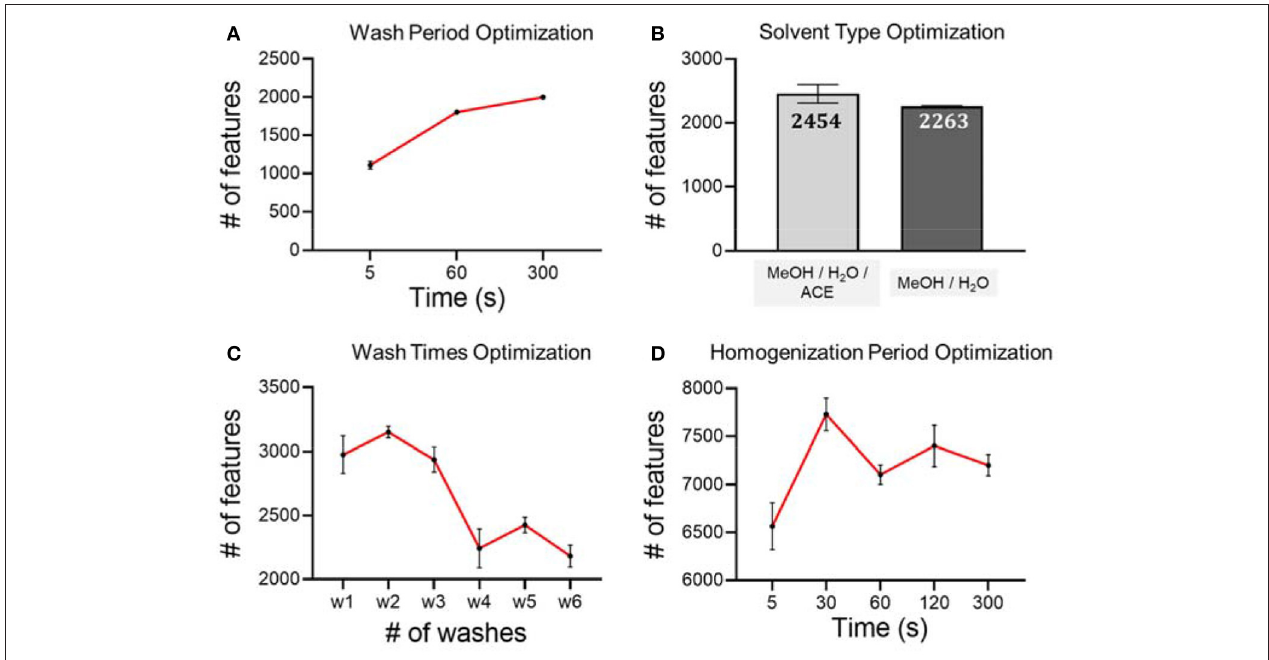
FIGURE 2 | Optimization of experimental conditions using RP ( + ) mode and analytical triplicates. (A) Hair washing period; (B) hair washing solvent; (C) hair washing times; (D) hair homogenization period.